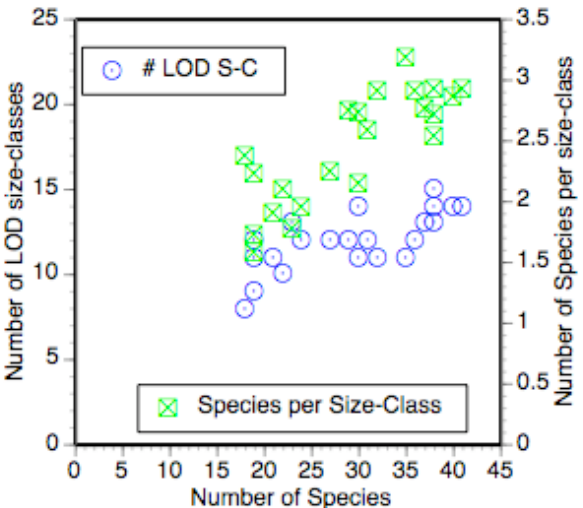
Fig. 6. Species packing in tintinnid communities across the SE Pacific Ocean. Comparing the different stations, both the number of mouth sizes, lorica oral diameter LOD in 4 µ m size – class intervals, and the average number of species per mouth size increased with the number of species.